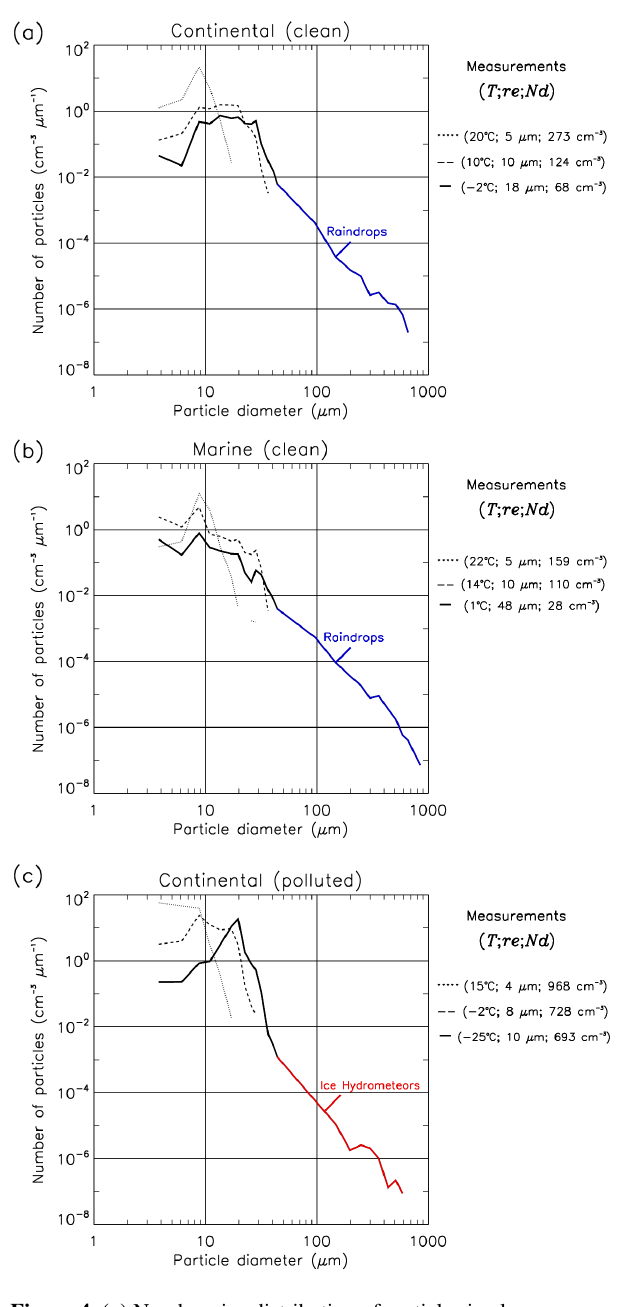
Figure 4. (a) Number size distribution of particles in clean convec- tive clouds measured during flight AC09 for different r e and temper- atures ( T ). The values of r e , the number concentration of particles ( N d ), and T for each case are shown on the right side of the pan- els. Panels (b) and (c) are similar to (a) for marine clouds measured during flight AC19 and for polluted clouds measured during flight AC13, respectively. Particles with precipitating sizes (raindrops and ice hydrometeors) are indicated by colors.